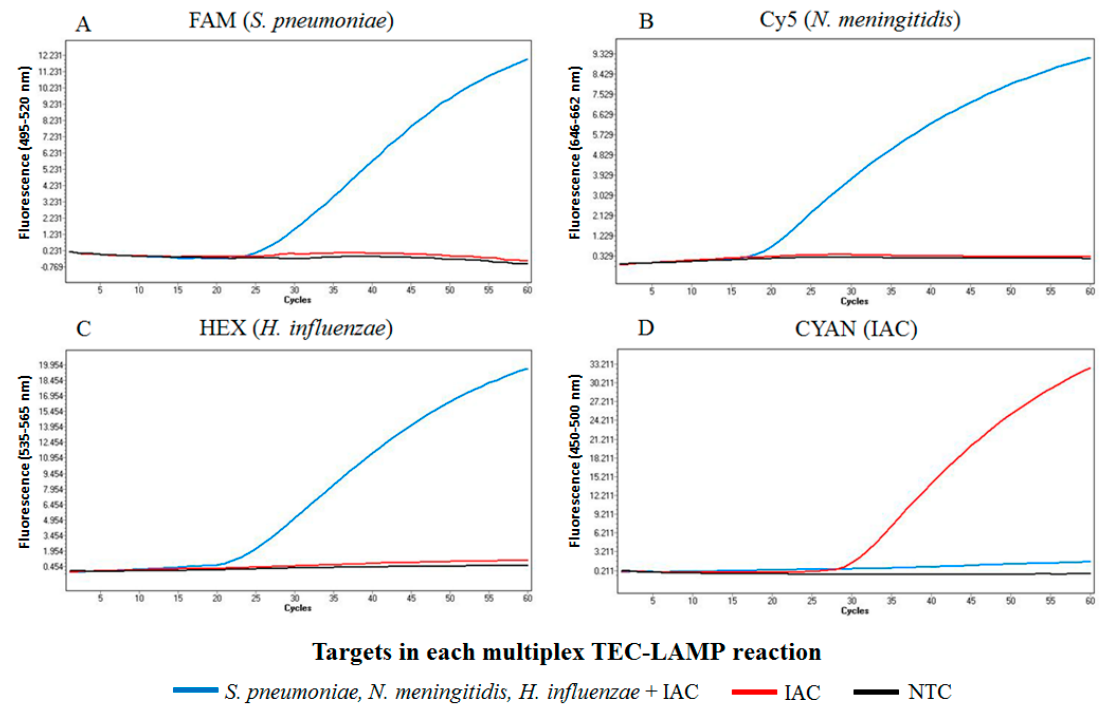
Figure 2. Internally controlled multiplex TEC-LAMP detection. The four graphs show fluorescence recorded in the FAM ( A ), Cy5 ( B ), HEX ( C ) and CYAN ( D ) LightCycler ® 480 detection channels, for three TEC-LAMP reactions performed in parallel. These reactions included: (blue) 100 genome copies S. pneumoniae , N. meningitidis and H. influenzae in the presence of 50 copies IAC; (red) no bacterial template in the presence of 50 copies IAC; and (black) a NTC reaction using molecular grade water in place of bacterial or IAC templates. Successful simultaneous detection of all three bacterial targets in the presence of the IAC was observed (blue: A – C ). The two control reactions performed successfully as detection of the IAC in the absence of bacterial target was observed (Red: D ), and no detection was observed in the NTC reaction (Black: A – D ).